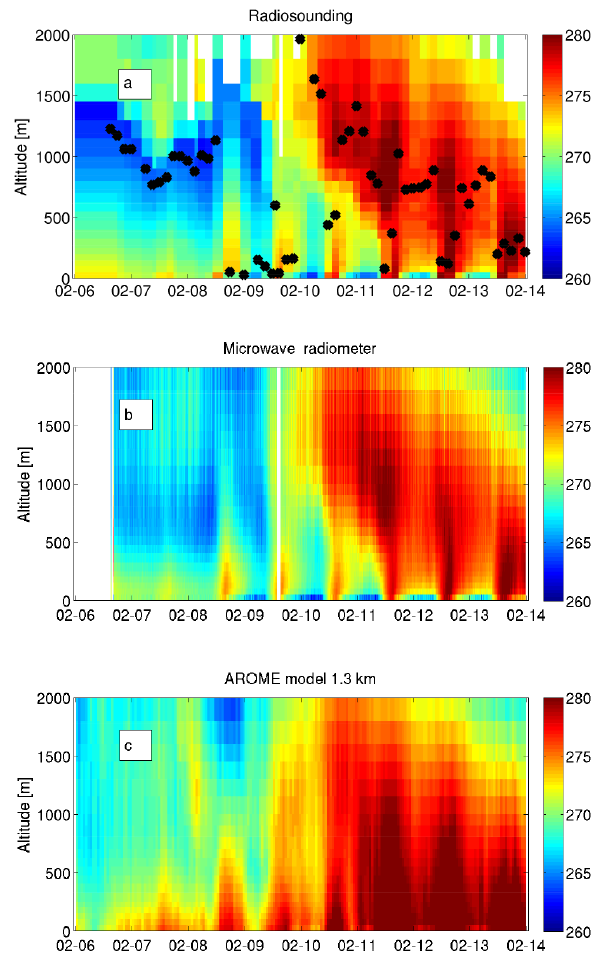
Figure 2. Time series of temperature profiles during IOP 1: (a) from radiosounding with corresponding boundary layer heights (black crosses); (b) from microwave radiometer; (c) from AROME analy- ses. Altitudes are given in meters above ground